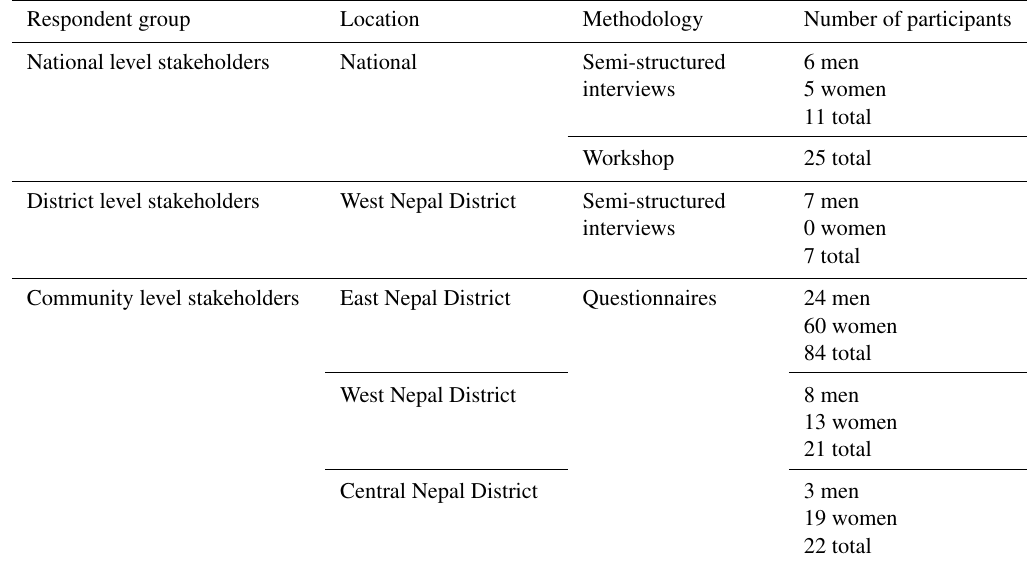
Table 1. Summary of participants and data collection